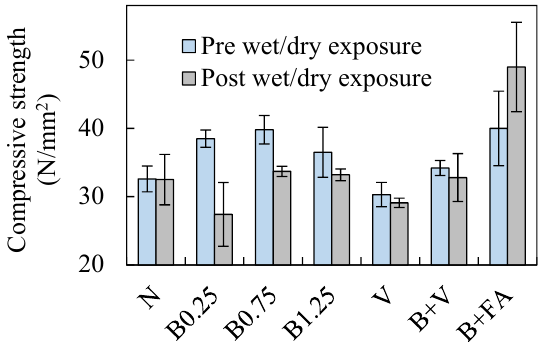
Figure 3. Compressive strength of mortar measured in laboratory